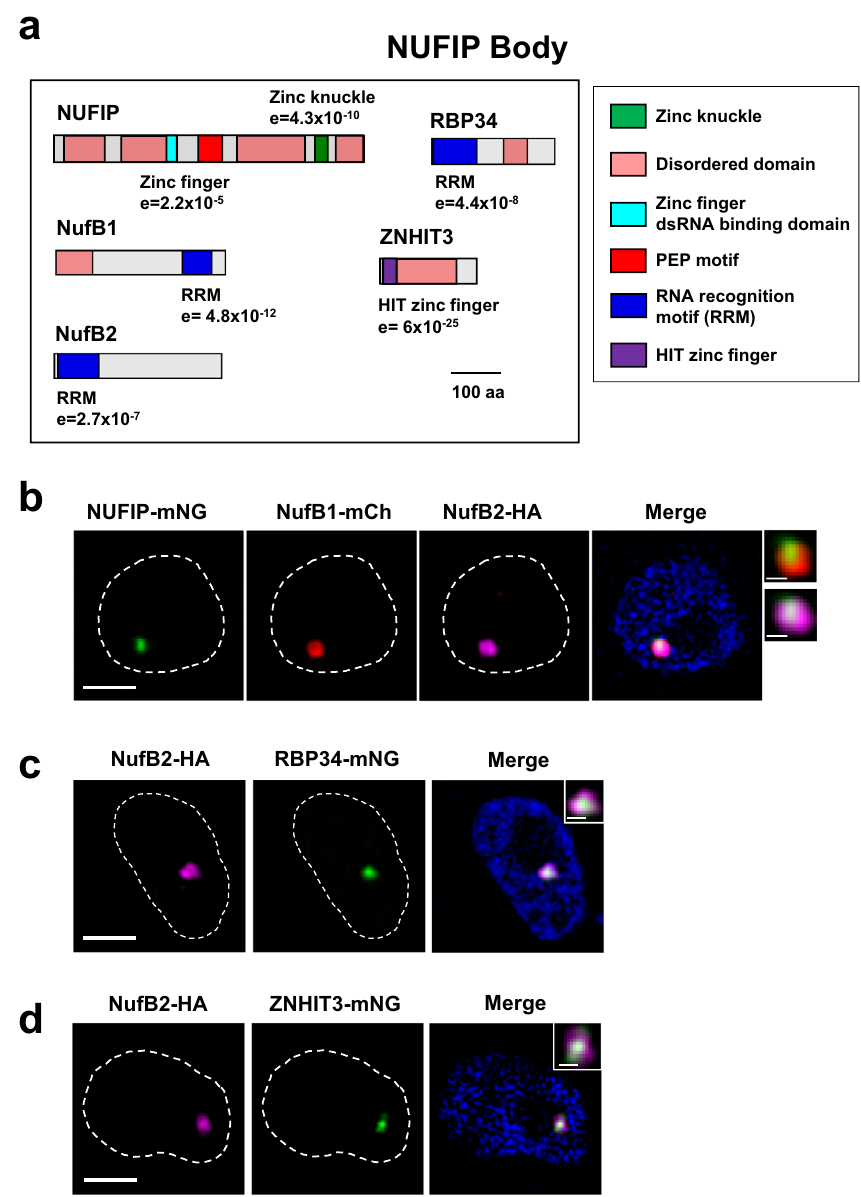
Fig. 4 Identi fi cation of a novel NUFIP body. a Schematic of NUFIP body components: NUFIP, RBP34, ZNHIT3 and the newly identi fi ed NufB1 and NufB2 proteins. Relevant protein domains and motifs were identi fi ed using PFAM, and disordered domains with PONDR (coloured boxes). b SR-SM imaging of a BF T. brucei cell line with three NUFIP components epitope-tagged. Signals in the nuclei (dashed lines) correspond to NUFIP::mNG (NUFIP-mNG, green), mCh::NufB1 (NufB1-mCH, red) and NufB2::6HA (NufB2-HA, magenta), with DNA stained with DAPI (blue). The insets show further magni fi cation of the foci, illustrating the ‘ shell ’ -like structure. Scale bar = 1 μ m for main images, and 200 nm for the insets. c As in ( b ), only showing SR-SM microscopy imaging of a BF cell line with two NUFIP body components epitope-tagged: NufB2::6HA (NufB2-HA, magenta) and RBP34::mNG (RBP34-mNG, green). d As in ( b ), but showing SR-SM microscopy imaging of a BF cell line with two NUFIP body components epitope-tagged: NufB2::6HA (NufB2-HA, magenta) and ZNHIT3::mNG (ZNHIT3-mNG,